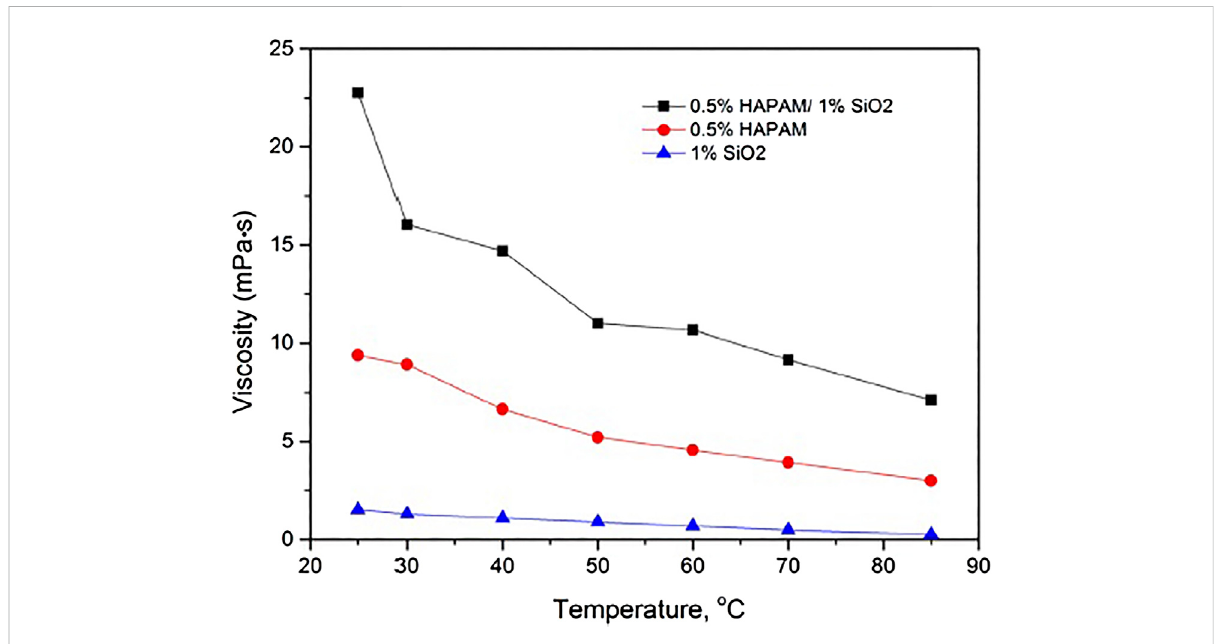
FIGURE 9 Viscosities of HAPAM, silica NP, and their combination. Effect of temperature (Hu et al.,